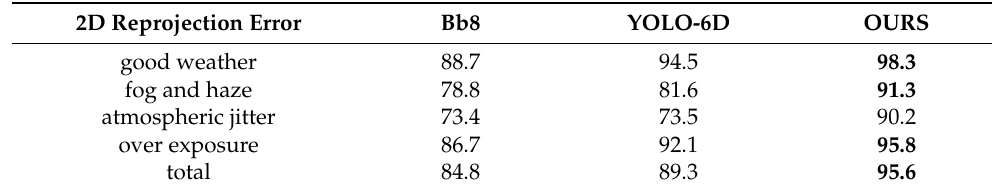
Table 2. Comparison with the state-of-the-art methods in terms of the 2D reprojection metric on APE dataset. Bold number indicates the best results.